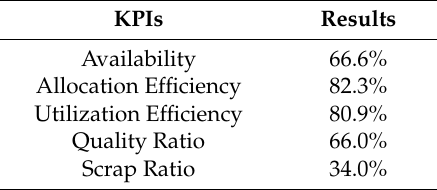
Table 3. KPIs results obtained after executing an example production order.